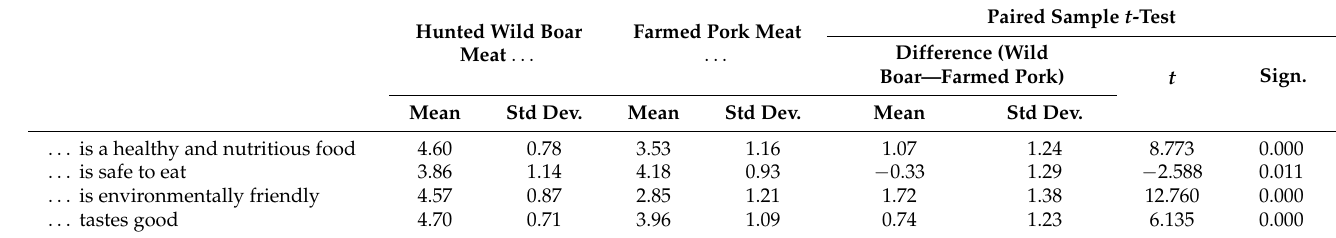
Paired Sample t